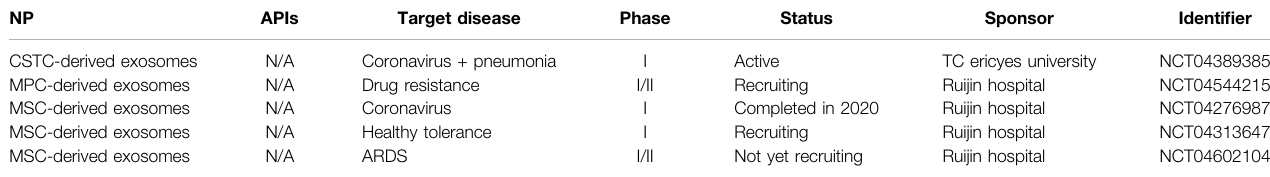
TABLE 6 | A summary of current clinical trials for erosolized